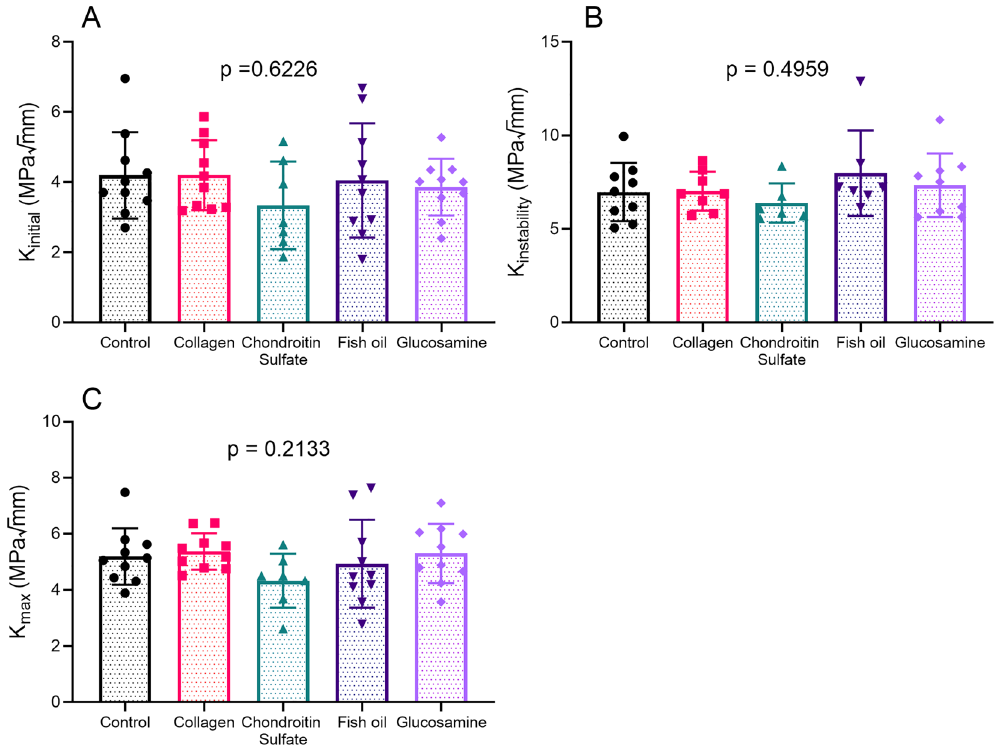
Figure 2. Fracture toughness parameters of tibiae of critical stress factors ( A ) initial energy, ( B ) instability energy, and ( C ) max energy. Overall ordinary one way ANOVA or Kruskal Wallis p values are given above